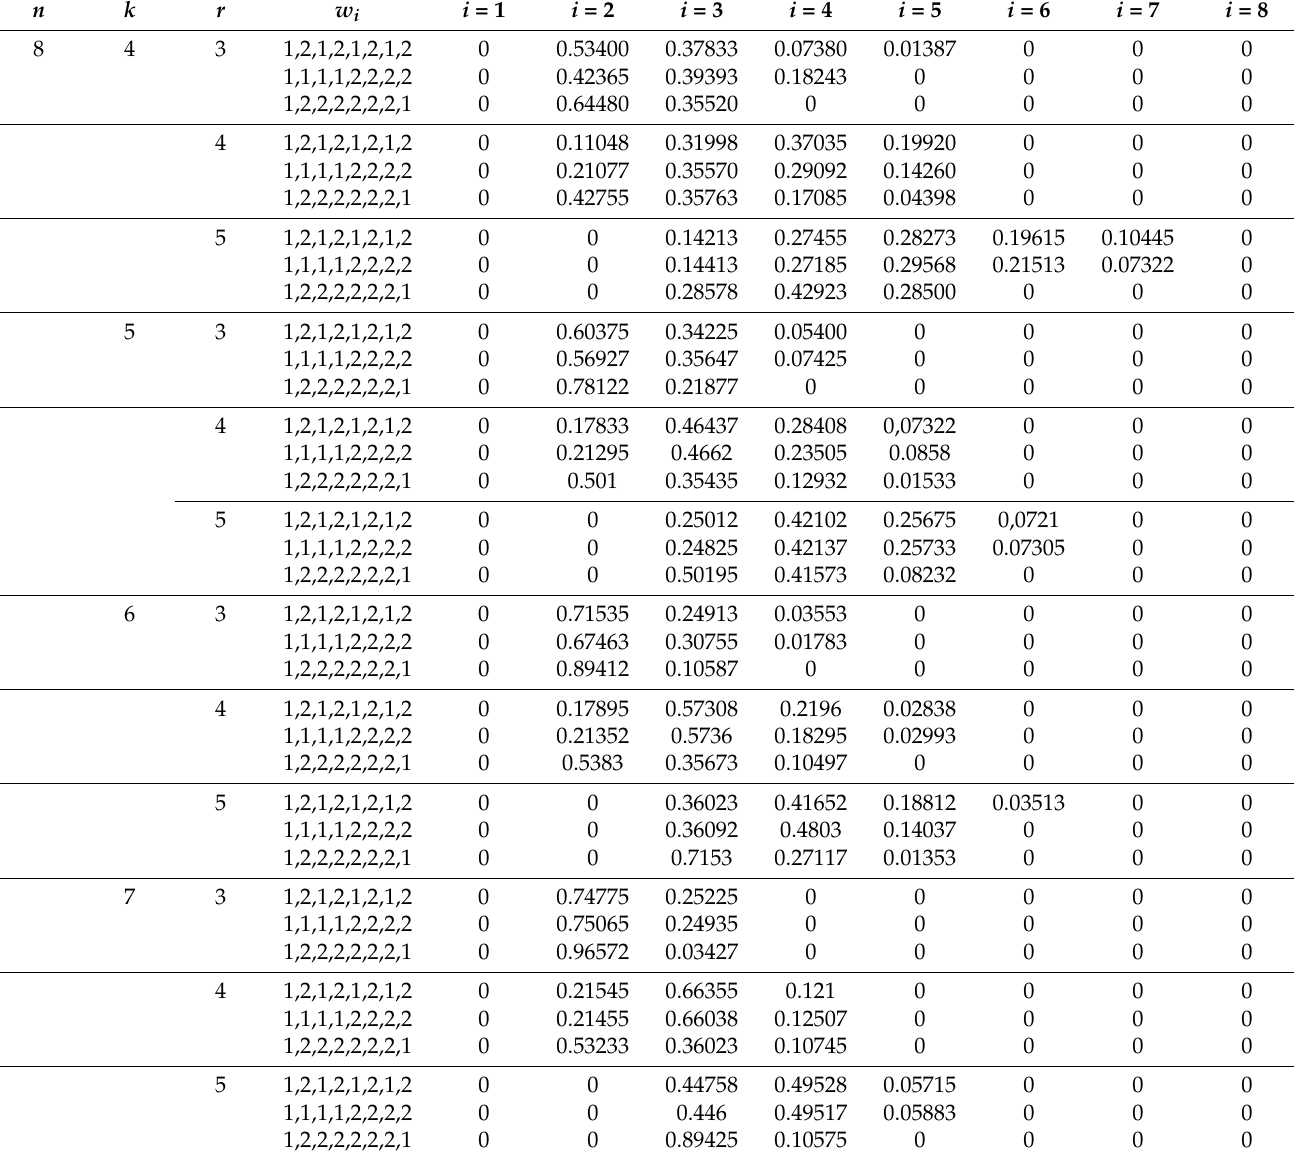
Table 4. The signature of the weighted- r -within-consecutive- k -out-of-8: F